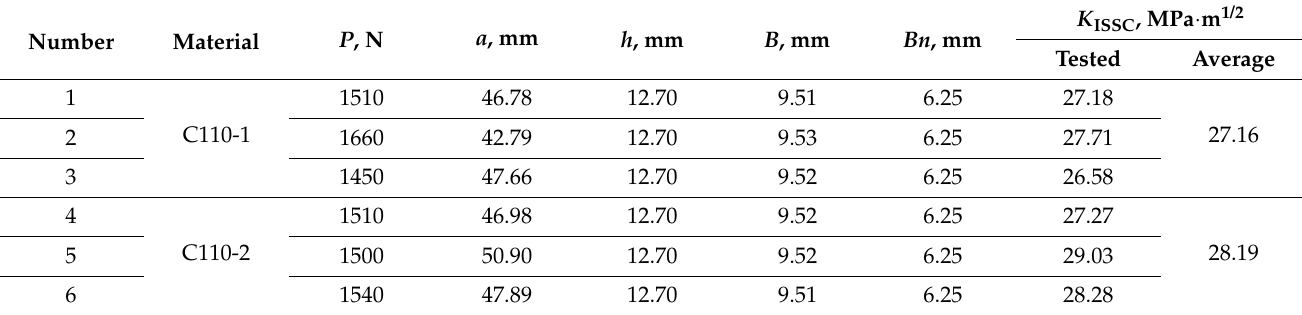
Table 6. Test results of fracture ductility: K ISSC values of C110-1 and C110-2.